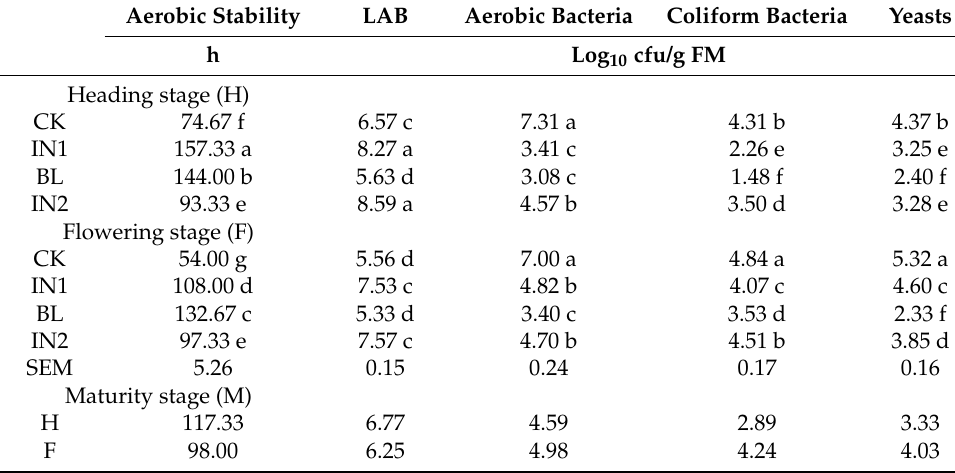
Table 3. Aerobic stability and microbial compositions of perennial oat silages treated without (CK) or with local LAB inoculant (IN1), commercial LAB inoculant (IN2), and sodium benzoate